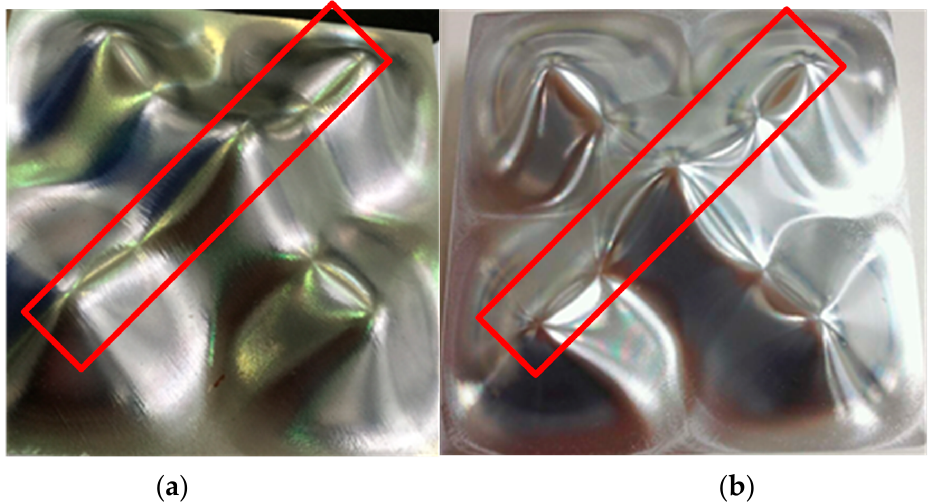
Figure 15. Machining comparison of Wuzhishan transition surface ( a ) before optimization ( b ) after optimization.